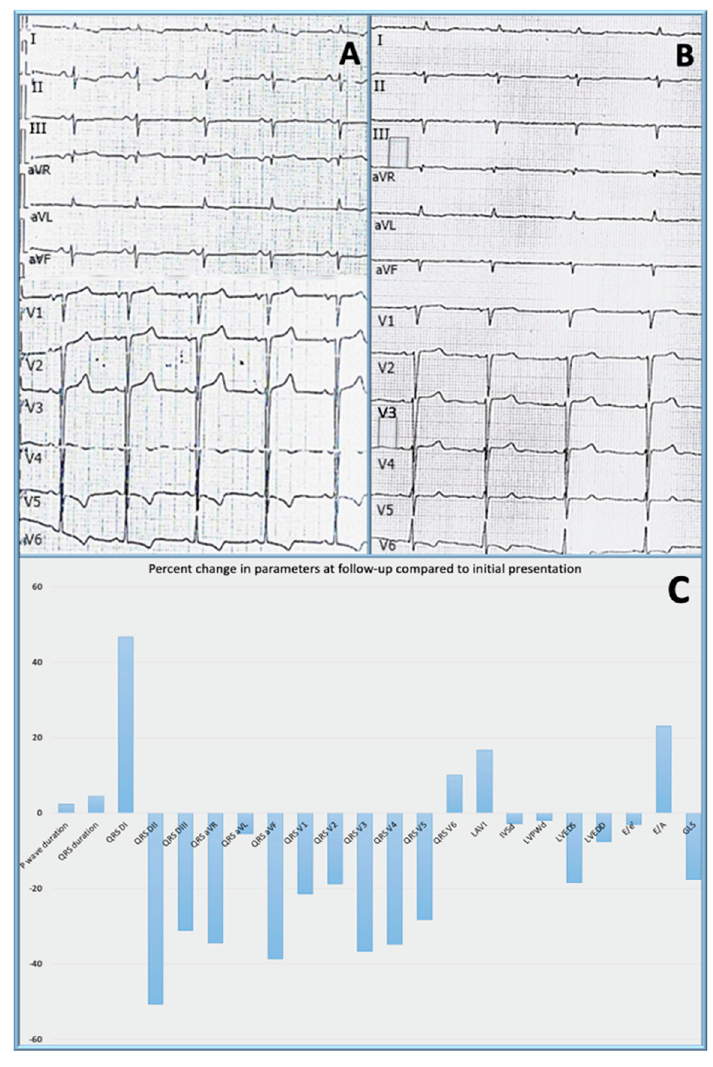
Figure 1. Electrocardiogram at baseline ( A ) and at follow-up ( B ) and percent changes in electrocardiographic and echocardiographic parameters at 9 months follow-up compared to the initial presentation; QRS DI − QRS V6 = QRS voltage in all 12 leads of the standard electrocardiogram; LAVI = left atrial volume index; IVSd = interventricular septum in diastole; LVPWd = left ventricular posterior wall in diastole; LVEDS = left ventricular end-diastolic diameter in systole; LVEDD = left ventricular end-diastolic diameter in diastole; E/e ′ = mitral E/e ′ ratio; E/A = mitral ratio between the maximal velocity of transmitral flow in early to late diastole; GLS = global longitudinal strain, presented as change in absolute value ( C ); QRS voltage measured as average of three consecutive beats, using digital calipers at 300% magnification calibrated for paper speed of 25 mm/s. Transthoracic echocardiography (TTE) revealed a speckled hyperechoic appearance of the myocardium and symmetric LVH. In addition, there was thickening of atrial walls, right ventricular walls, atrial septum, valves and papillary muscles (Figure 2A). There was also biatrial enlargement and the left ventricular ejection fraction was preserved (52%). The diastolic function parameters were suggestive of elevated filling pressure. The mitral E/A ratio was 1.3. Tissue Doppler e ′ velocity was reduced, with septal E/e ′ ratio of 32.1 and lateral E/e ′ of 17.8. Global longitudinal strain (GLS) imaging was − 11.4%, with the bull’s eye plot (Figure 2B) revealing a ‘relative apical sparing’ characteristic for CA.